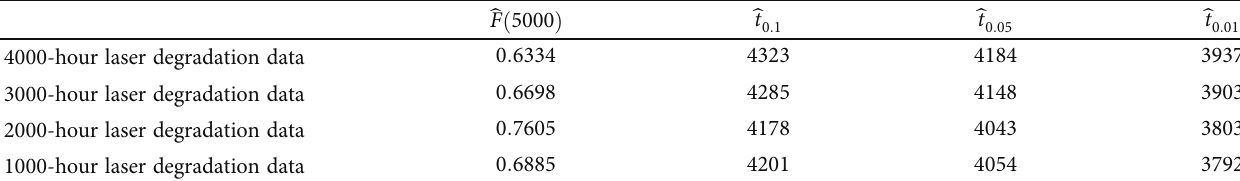
Table 6: Estimation of the probability of failing by 5000 hours and lower distribution